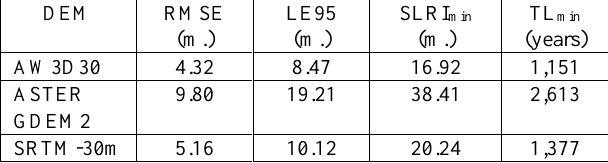
Table 3. Computed values of parameters related to the vertical uncertainties of the DEMs based on the use of all GCPs. TL min was computed assuming an annual SLR rate of 14.7 mm/year.